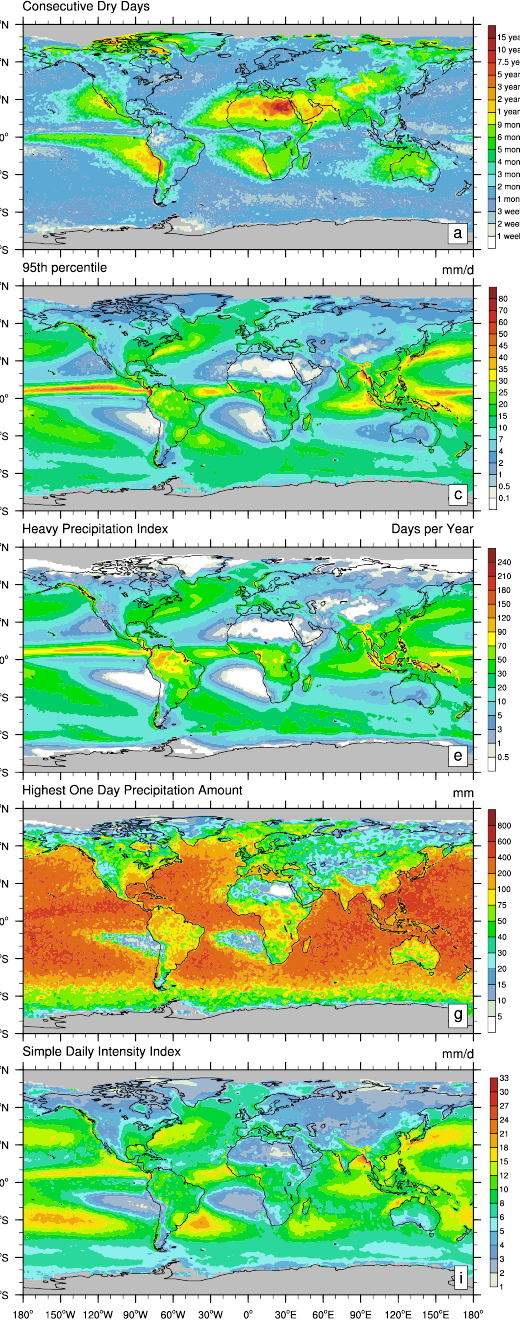
Figure 5. DAPACLIP ETCCDI climatology for the period 1988–2008 for all indices listed in Table 1. Panel ( a ): consecutive dry days (cdd). Panel ( b ): consecutive wet days (cwd). Panel ( c ): 95th percentile of precipitation (r95p). Panel ( d ): 99th percentile of precipitation (r99p). Panel ( e ): Heavy precipitation index (r10). Panel ( f ): Very heavy precipitation index (r20). Panel ( g ): Maximum one day precipitation (rx1). Panel ( h ): Maximum five day precipitation (rx5). Panel ( i ): Simple daily intensity index